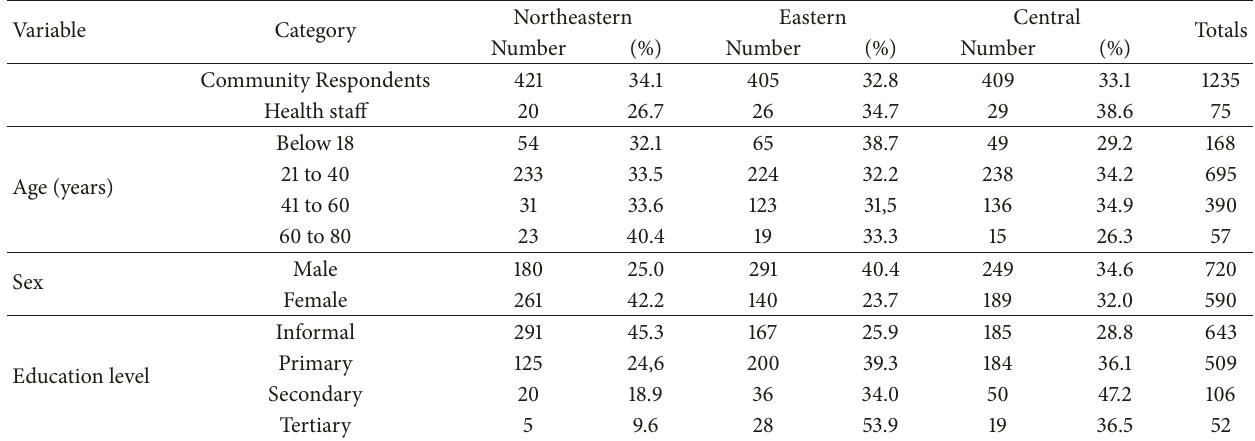
Figure 1: Map of Uganda showing the selected study regions. Table 1: Sociodemographic characteristics (distribution) of